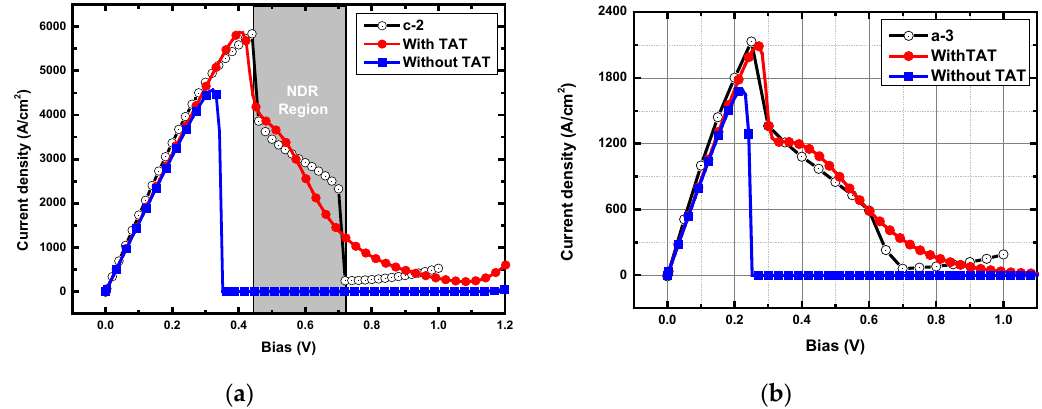
Figure 8. Simulated J-V curve with and without using the trap-assisted tunneling (TAT) model. The experimental data is from the sample ( a ) c-2 and ( b ) a-3.